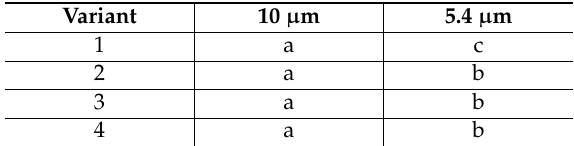
Figure 5. Simplified pixel layouts showing fully overlapping DDE over the p-well with ( a ) and without ( b ) notch around the sense node; and partially overlapping DDE ( c ). The sense node and the three transistors are not shown for simplicity. Table 1. Summary of the pixel design variants with layouts shown in Figure 5.